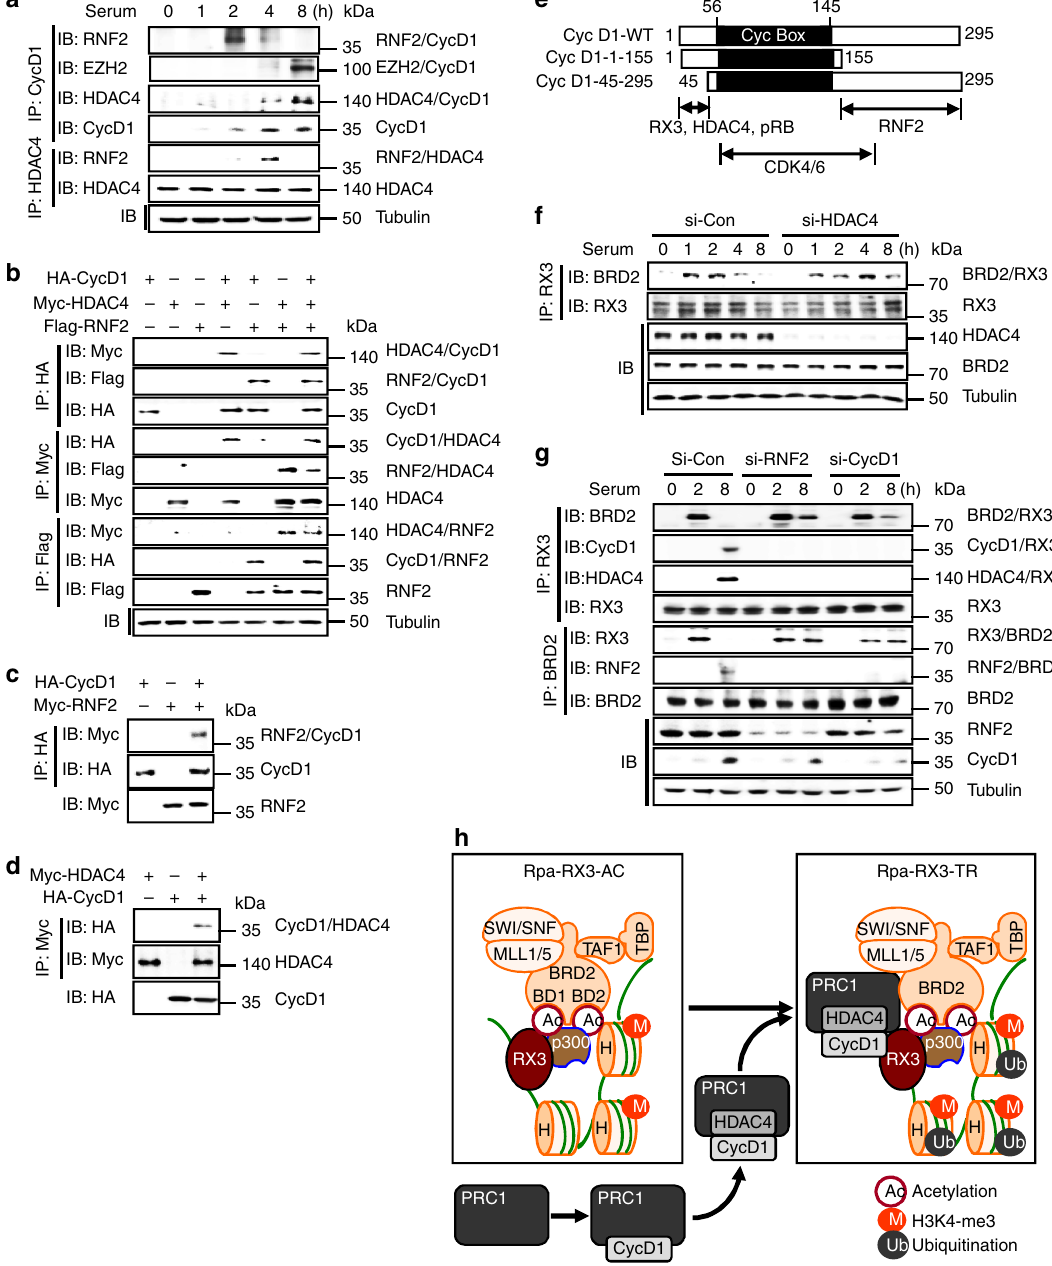
Fig. 3 Formation of the PRC1 – CyclinD1 – HDAC4 complex. a HEK293 cells were serum-starved for 24 h, and then stimulated with 10% serum. Cells were harvested at the indicated time points. Time-dependent formation of the RNF2 – Cyclin D1, EZH2 – Cyclin D1, HDAC4 – Cyclin D1, and RNF2 – HDAC4 complexes was measured by IP and IB. b HEK293 cells were transfected with HA-Cyclin D1, Myc-HDAC4, and Flag-RNF2, and the interactions between the proteins were measured by IP and IB. c , d HA-Cyclin D1, Myc-RNF2, and Myc-HDAC4 were translated in vitro and the interactions among the proteins were measured by IP and IB. e Regions of Cyclin D1 required for the interaction with RUNX3, RNF2, and HDAC4 are summarized. Cyclin D1 regions known to interact with pRB and CDK4/6 are also indicated. Cyc Box = Cyclin Box. f HEK293 cells were treated with control or HDAC4-speci fi c siRNA (si-con or si-HDAC4), serum-starved for 24 h, and then stimulated with serum for the indicated durations. Time-dependent formation of the BRD2 – RUNX3 complex was measured by IP and IB. g HEK293 cells were treated with control, RNF2-speci fi c, or Cyclin D1-speci fi c siRNA (si-con, si-RNF2, or si-CycD1), serum- starved for 24 h, and then stimulated with serum for the indicated durations. Time-dependent formation of the BRD2 – RUNX3, Cyclin D1 – RUNX3, HDAC4 – RUNX3, and RNF2 – BRD2 complexes was measured by IP and IB. h Schematic illustration of the process of Rpa-RX3-TR formation. Cyclin D1, which is induced 2 h after serum stimulation, interacts with PRC1 (containing RNF2) and matures into the PRC1 – CyclinD1 – HDAC4 complex. The PRC1 – CyclinD1 – HDAC4 complex then interacts with Rpa-RX3-AC to form